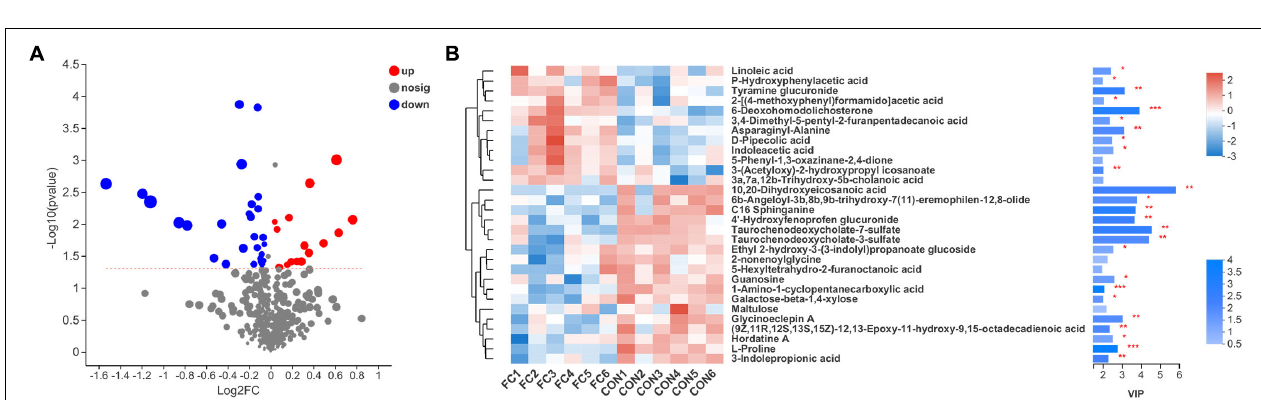
FIGURE 5 | Difference of serum metabolite profiles of ewes with follicular cyst or normal follicle. (A) PCA score plot for serum metabolites of ewes with follicular cyst or normal follicle. (B) PLS-DA score plot for serum metabolites of ewes with follicular cyst or normal follicle. (C) The model overview showing high R2Y and Q2 in PLS-DA. The values of R2Y and Q2 were 0.998 and 0.878, respectively. FC represents ewes with follicular cysts and CON represents ewes with normal follicle.